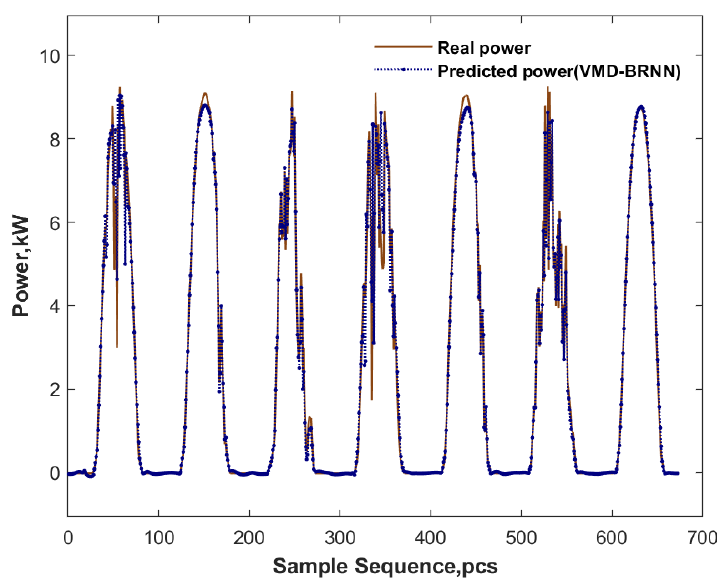
Figure 6. VMD-BRNN model prediction